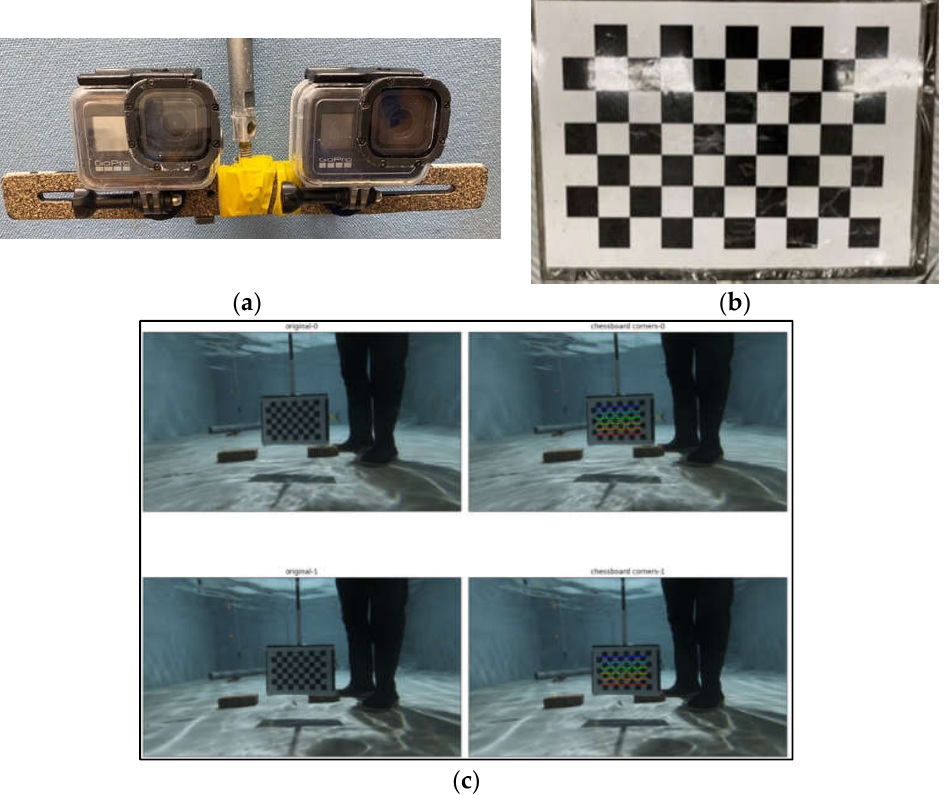
Figure 5. Set-up of the low-cost stereo camera system: ( a ) the stereo camera; ( b ) the correction